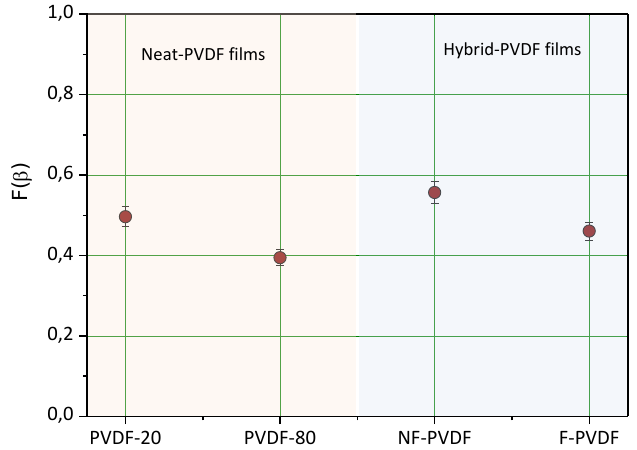
Figure 3. β -phase content for neat PVDF films (PVDF-20 and PVDF-80) and hybrid ones with non-functionalized nanoparticles (NF-PVDF) and functionalized nanoparticles (F-PVDF). IR observations support the conclusion that both neat PVDF films and hybrid ones